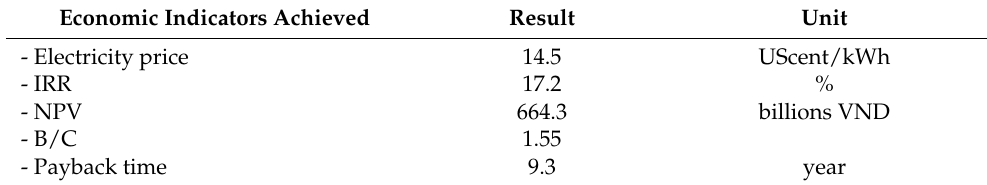
Table 6. Economic analysis results.